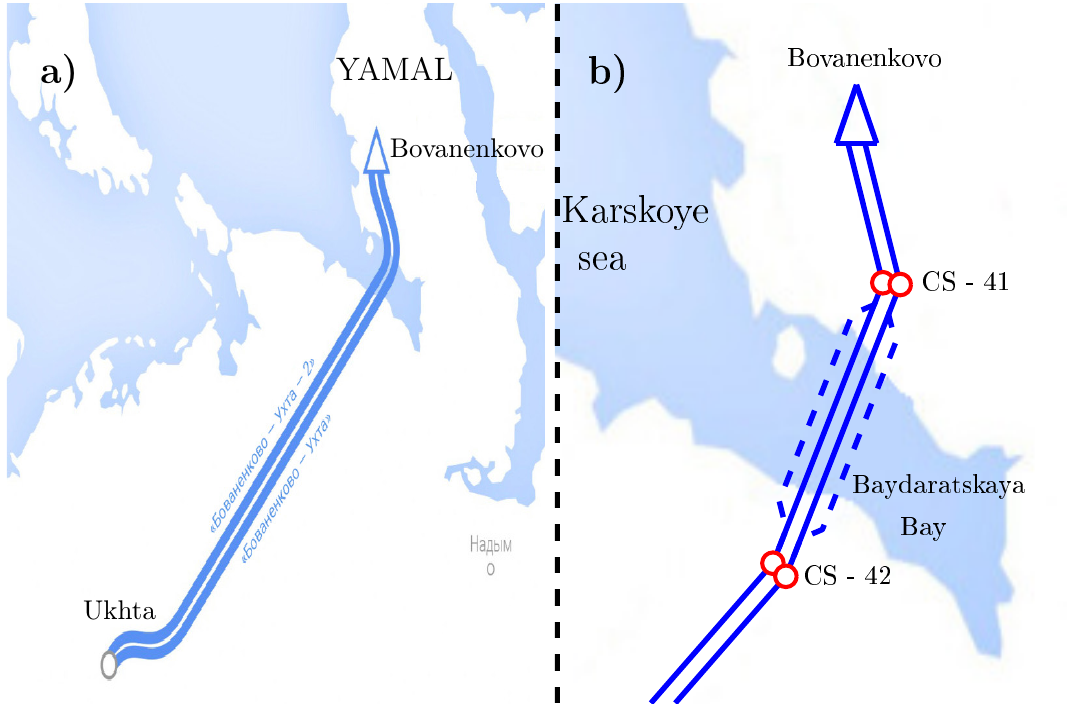
Figure 1. ( a ) The Bovanenkovo–Ukhta gas pipeline. ( b ) The crossing through the Baydaratskaya